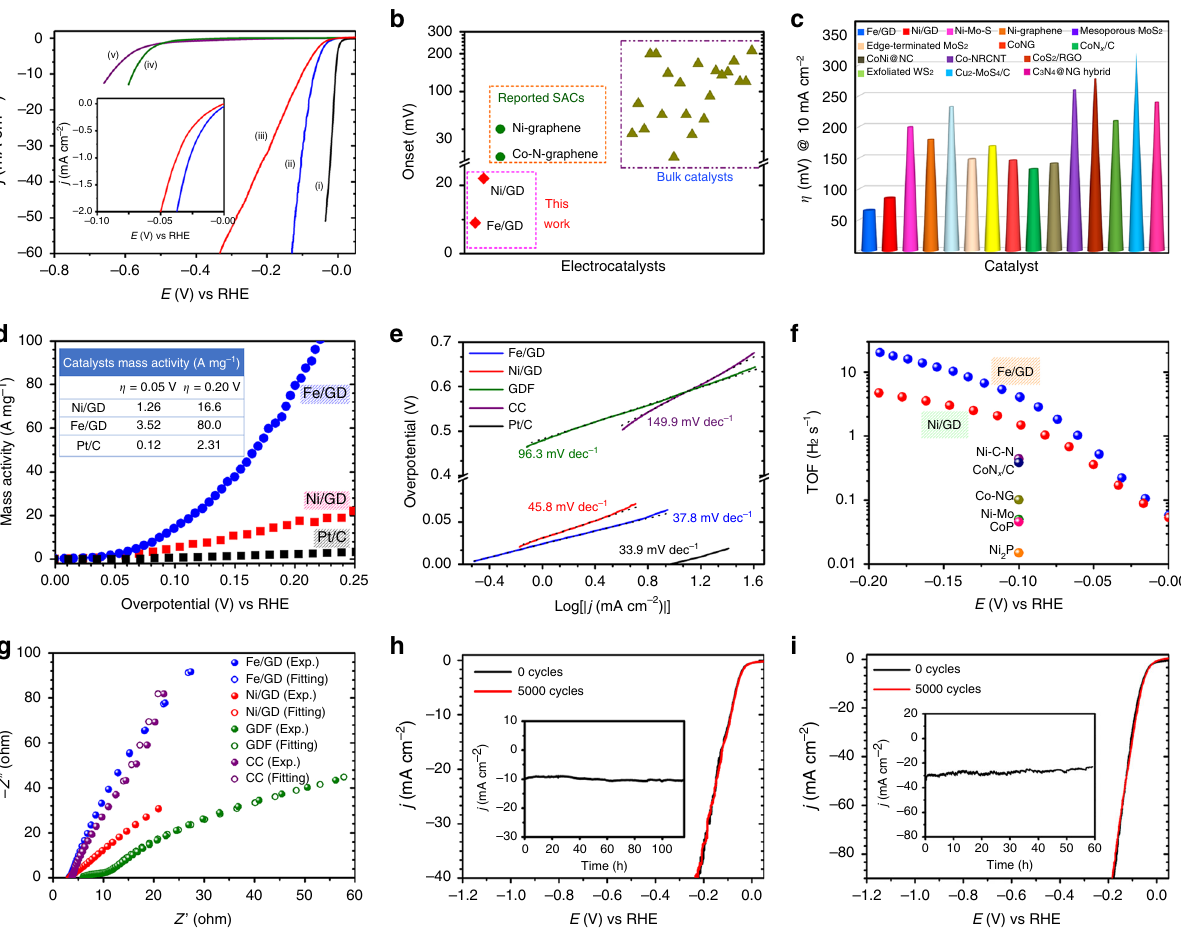
Fig. 5 HER activities and stabilities of Ni/GD and Fe/GD. a Polarization curves of (i) Pt/C, (ii) Fe/GD, (iii) Ni/GD, (iv) GDF, and (v) CC (inset: enlarged view of the LSV curves for Fe/GD and Ni/GD near the onset region). b Onset values and c overpotentials at 10 mA cm − 2 of Ni/GD and Fe/GD (red square) along with other nonprecious single-atom HER catalysts (green circle) and several bulk catalysts (olivine triangle). d Mass activities of Ni/GD, Fe/ GD, and Pt/C (inset: mass activities obtained at overpotentials of 0.05 and 0.20 V). e Tafel plots of the presented data in a . f TOF values of Fe/GD (blue dot) and Ni/GD (red dot) together with several state-of-the-art HER electrocatalysts. g Nyquist plots of experimental data (dots) and fi tting results (circles) for Fe/GD, Ni/GD, GDF, and CC. Stability tests of h Ni/GD and i Fe/GD (insets: respective time-dependent current density performance of ACs. After excluding the effects of scanning rate on HER performance (Supplementary Fig. 14), we evaluated the HER catalytic activity of the Fe/GD and Ni/GD ACs in H 2 - saturated 0.5 M H 2 SO 4 using a standard three-electrode system (the reference electrodes were calibrated daily with respect to reversible hydrogen electrode (RHE), Supplementary Fig. 15). GDF, CC, and Pt/C (20 wt%) were used for comparison. In Fig. 5a, the rapid rise of current with the increasing of cathodic potential showed that Fe/GD and Ni/GD can act as high- performance electrodes for HER. Fe/GD exhibits the best HER activity with the smallest onset overpotential of 9 mV, which is very close to Pt/C (1.0 mV, Supplementary Fig. 16). Fe/GD shows an overpotential of 66 mV at 10 mA cm – 2 , which is smaller than that of Ni/GD (88 mV), GDF (578 mV), and CC (642 mV) (Fig. 5a – c). The values are superior to other earth-abundant HER – 2 ) 43 , MoS 2 (170 mA electrocatalysts [such as Ni 2 P (~110 mA cm cm – 2 ) 44 , and exfoliated WS 2 (210 mA cm – 2 ) 45 ], and even com- pare favorably with noble-metal-based electrocatalysts such as Pt nanowires/single-layered Ni(OH) 2 46 . Mass activity is one of the important evaluation criteria applied to characterize the catalytic performances in practical applications 47 . Remarkably, normalized to respective loading, both Fe/GD and Ni/GD possess sig- ni fi cantly better mass activity toward HER than commercial Pt/C